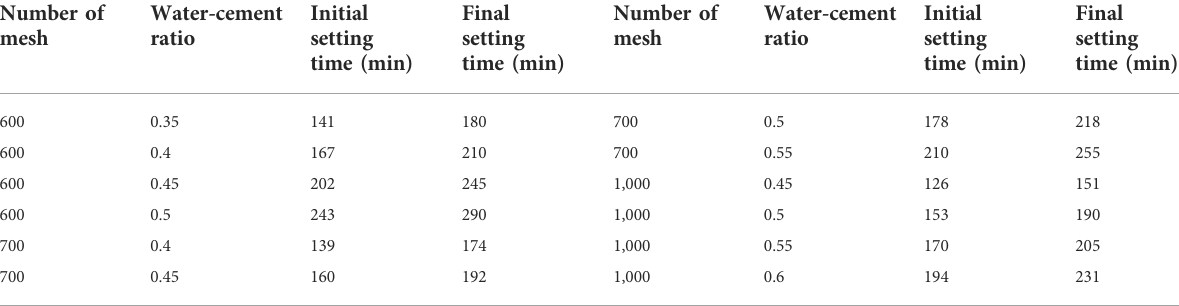
TABLE 5 Setting time of super fi ne cement with different water cement ratio. Number of Water-cement Initial mesh ratio